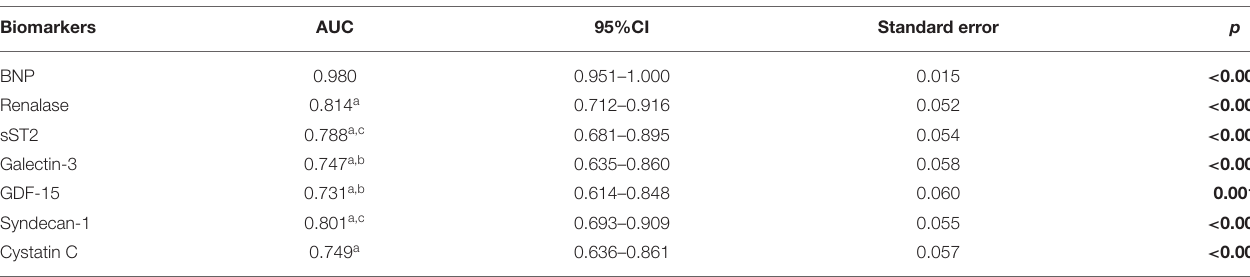
TABLE 5 | Areas under the ROC curves for prediction of ischemia in the HFrEF phenotype.